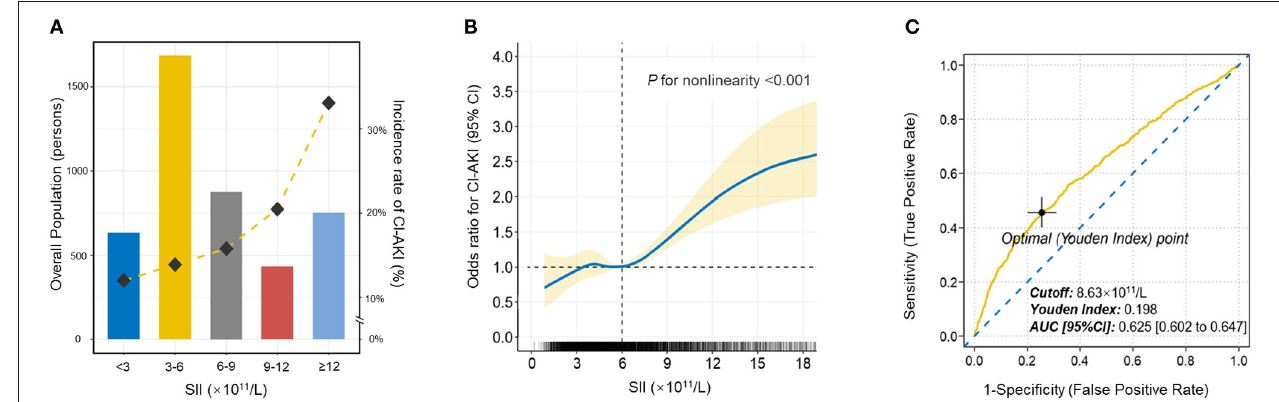
FIGURE 2 | The population distribution histogram, restricted cubic spline analysis and receiver operating characteristic curve. (A) The population distribution of the incidence of CI-AKI according to SII. The gold dashed line depicts the changing trend in incidence of CI-AKI. Left axis, population count (persons); right axis, incident rate of CI-AKI (%). (B) Restricted cubic spline analysis for exploring the non-linear association between SII and CI-AKI. The solid blue line shows the adjusted odds ratio of SII for CI-AKI, and the shaded area around the solid line indicates 95% confidence interval of the curve. (C) Receiver operating characteristic curve of SII for CI-AKI. According to the maximum Youden index, the optimal cut-off value was evaluated and pointed out in the figure. CI-AKI indicates contrast-induced acute kidney injury; SII, systemic immune-inflammation index; AUC indicates area under the curve; CI, confidence interval. (7.66 [4.48, 14.81] × 10 11 /L vs. 5.41 [3.60, 8.75] × 10 11 /L, P <